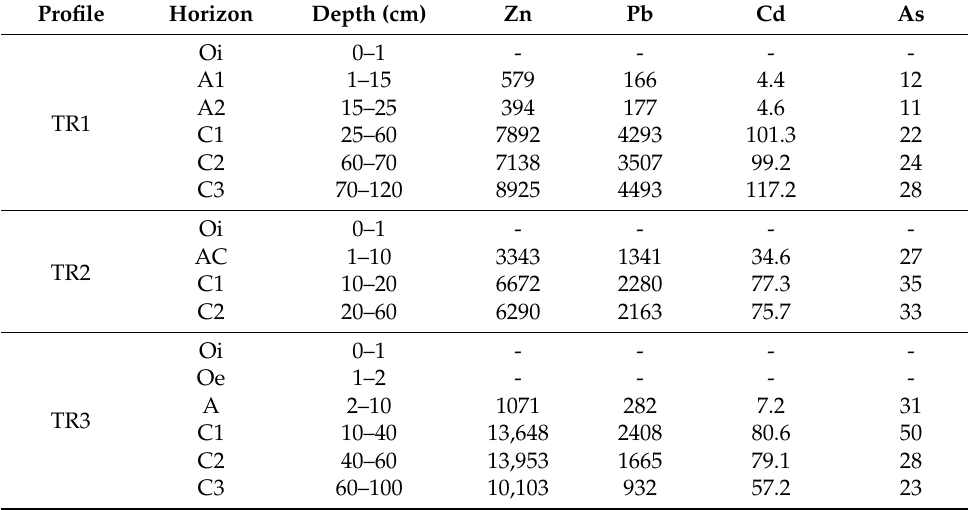
Table 5. Total concentrations of studied elements (in mg · kg − 1